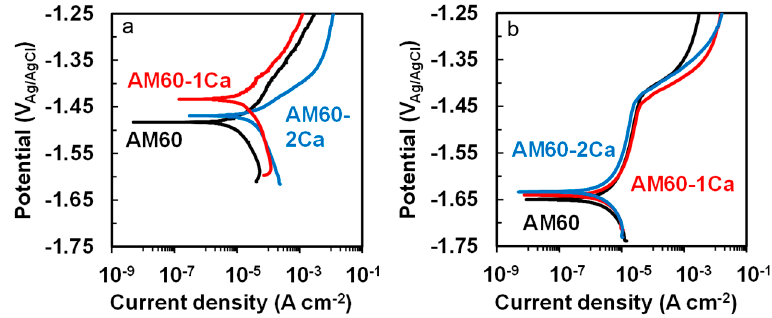
Figure 10. Potentiodynamic polarization curves of ( a ) substrates and ( b ) anodized specimens of AM60, AM60-1Ca, and AM60-2Ca in 0.9% NaCl solution at 37 °C. AM60-1Ca, and AM60-2Ca in 0.9% NaCl solution at 37 ◦